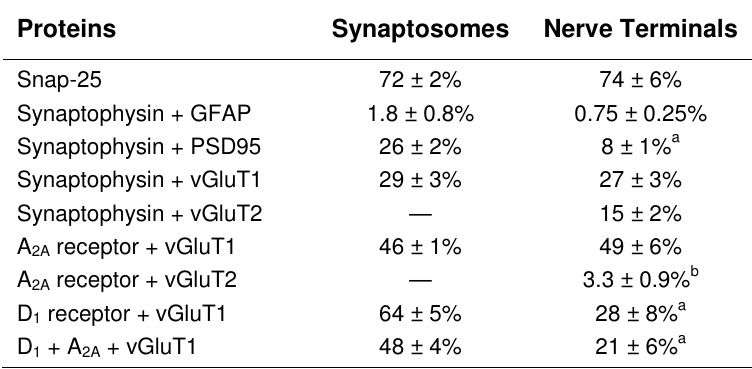
Immunolabeling of Pre- and Postsynaptic Proteins in Synaptosomal (Mixed Pre- and Postsynaptic Components) and Purified